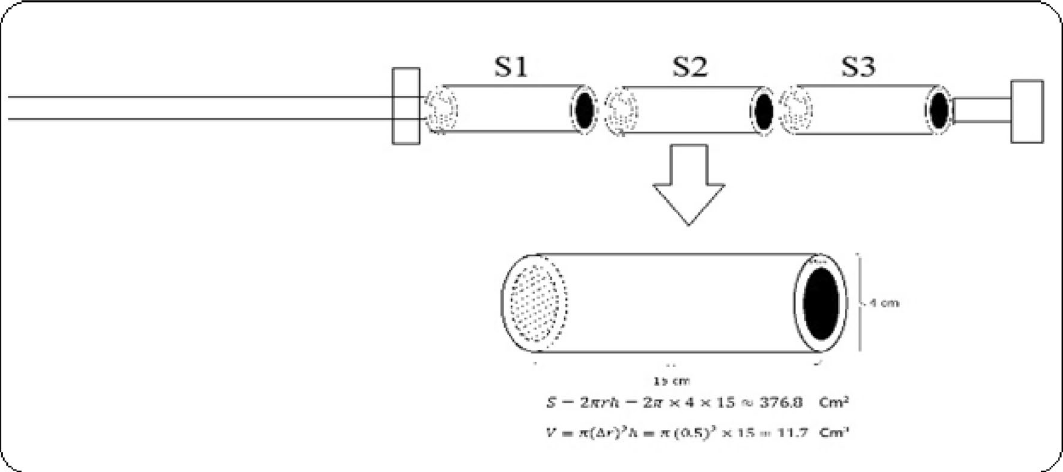
Figure 1. Schematic diagram of the structure and arrangement of circular surfaces collecting nettle venom. S1, S2 and S3 are three types of cylindrical circular surfaces: styrofoam, nanofabric and